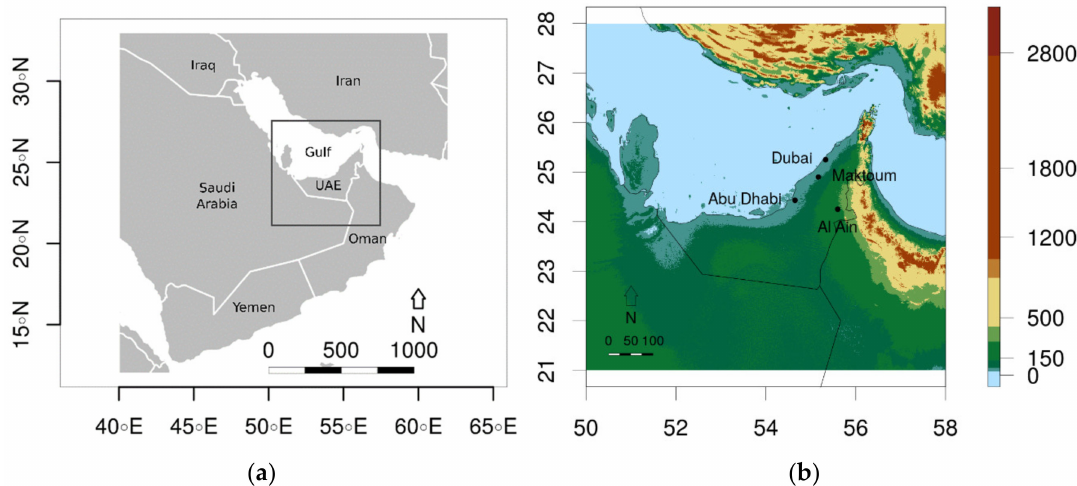
Figure 1. ( a ) The United Arab Emirates (UAE) is located on the Arabian Peninsula. ( b ) Terrain (m.a.s.l.) and location of meteorological aerodrome report (METAR) stations used for